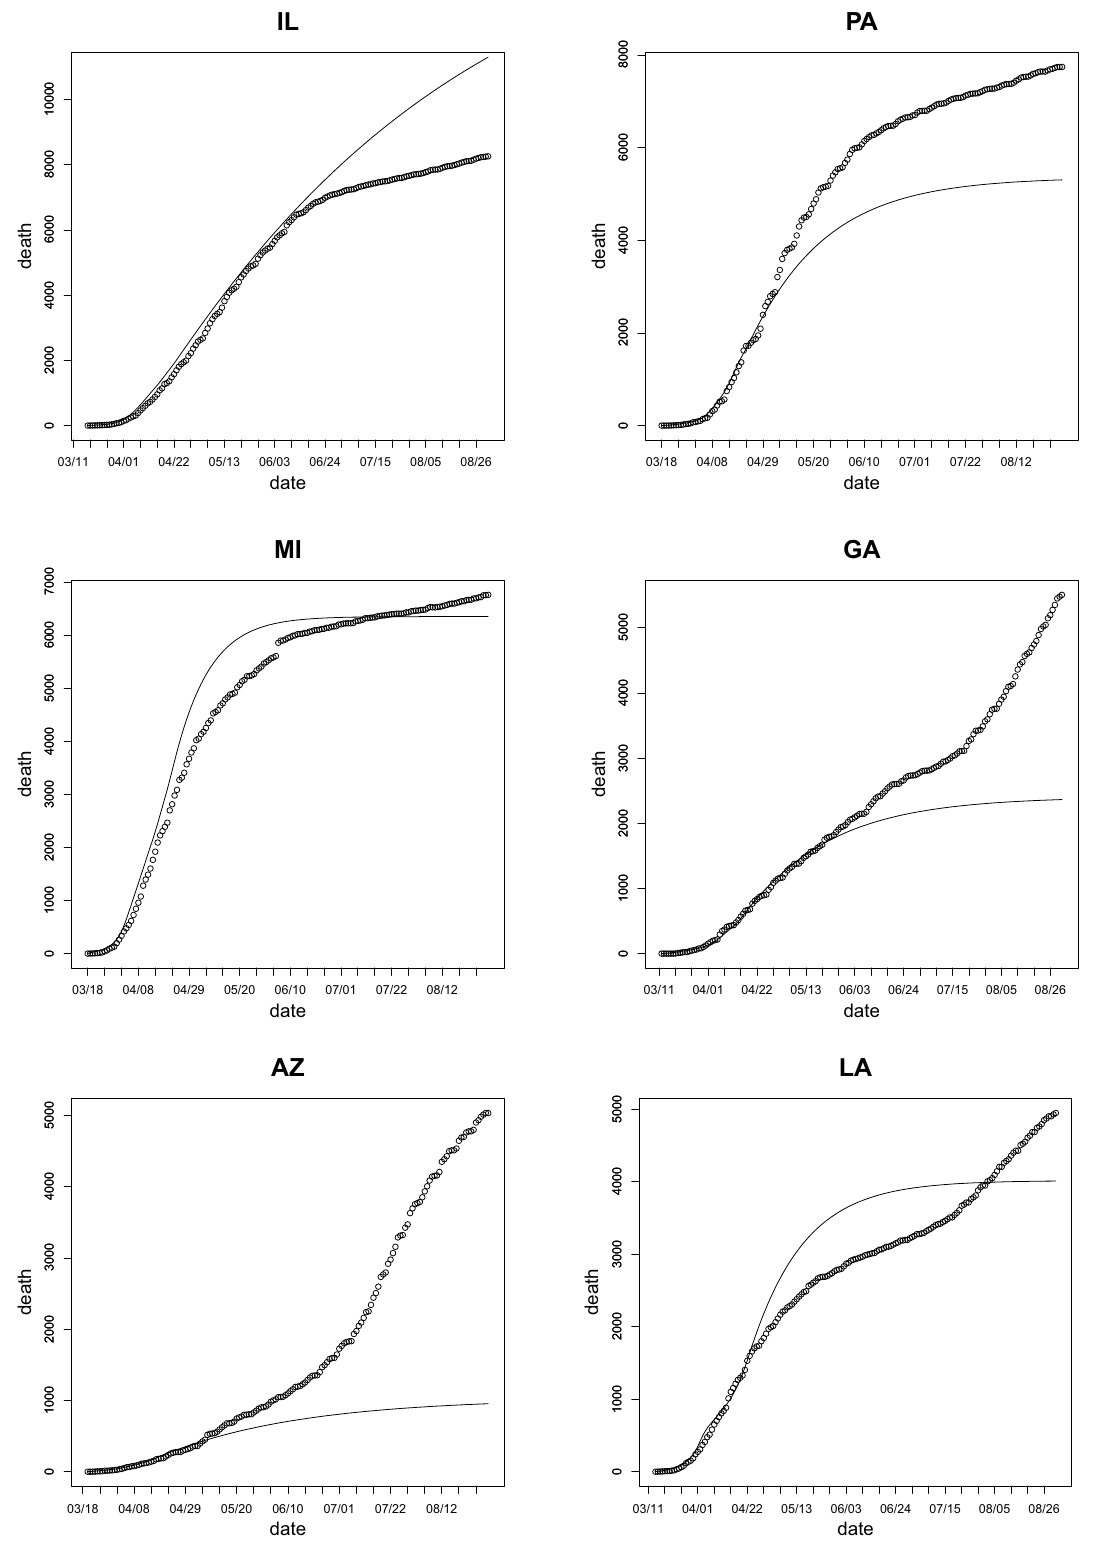
Figure 2. Total death count (dots) 80 and projected fatalities count without easing the mitigation efforts (solid line) as functions of time for the states of Illinois, Pennsylvania, Michigan, Georgia, Arizona, and Louisiana using estimate by the data before the end of